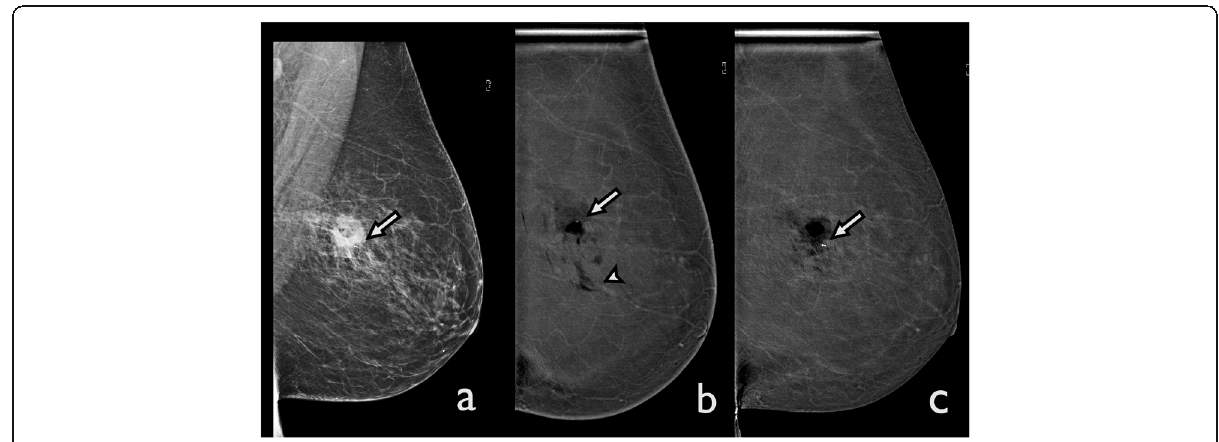
Fig. 1 Motion artefact. A ductal carcinoma in situ was diagnosed in the left breast after an ultrasound-guided core needle biopsy. CEDM was performed for preoperative staging. a The LE image shows a post-biopsy hematoma with a marker (arrow). b The recombined CEDM image demonstrates that the margins of the hematoma are blurred secondary to motion artefacts. Some black bands are visible (arrowhead), and the post-biopsy marker appears to be in a different position from the previous image (arrow). c A new recombined CEDM image was performed. Here, the motion artefacts are no longer visible, and the marker appears to be in the right position